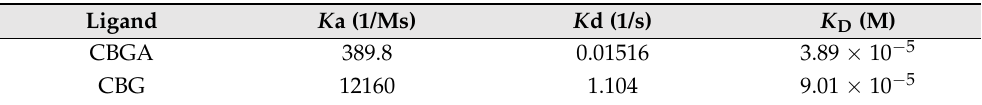
Table 2. M pro protein binding parameters ( K a, K d, and K D ) of CBGA and CBG obtained from the SPR experiments.